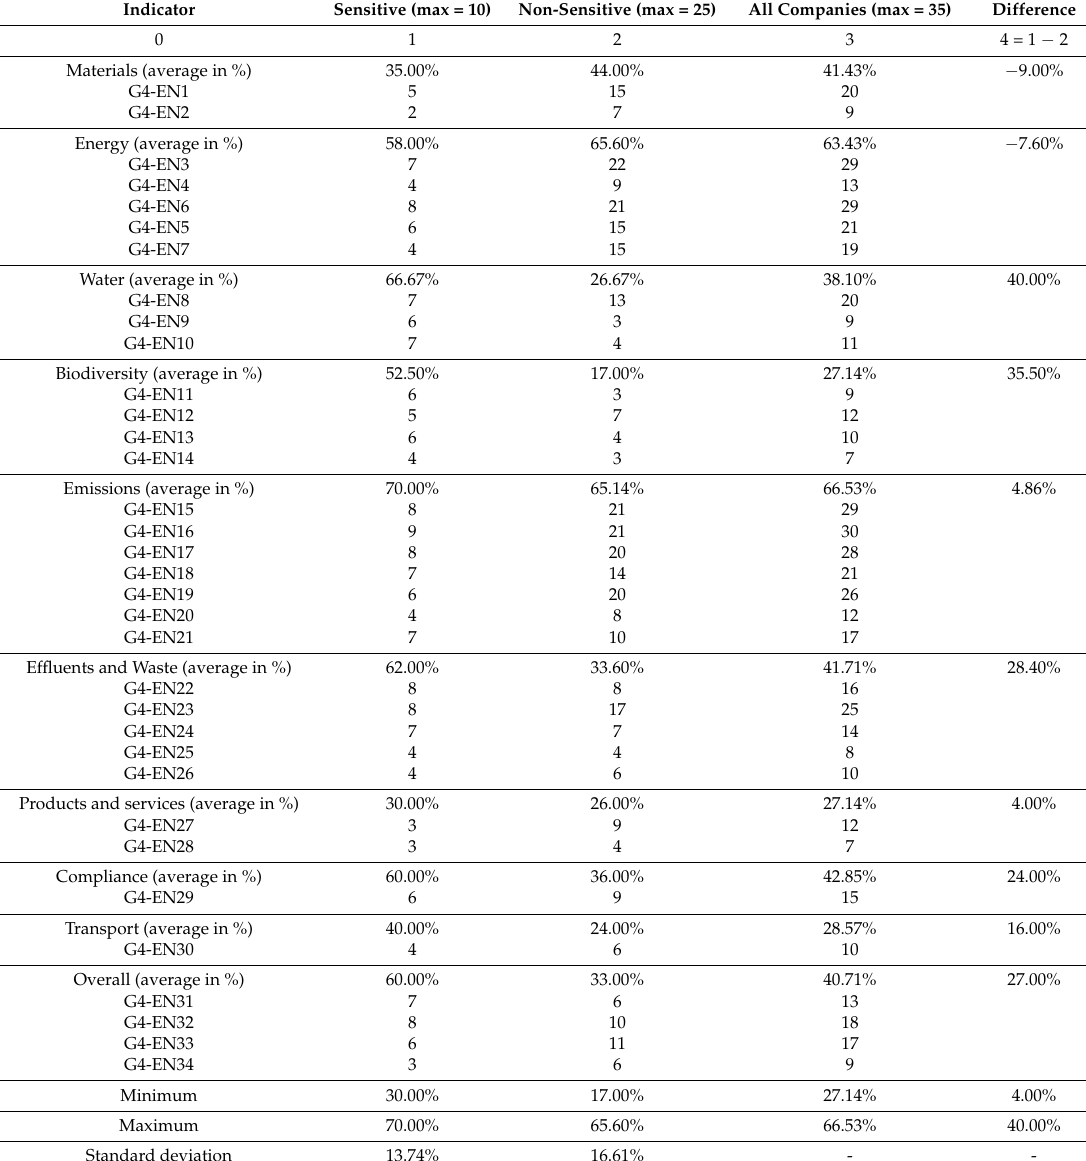
Table 3. Number of companies disclosing at least an